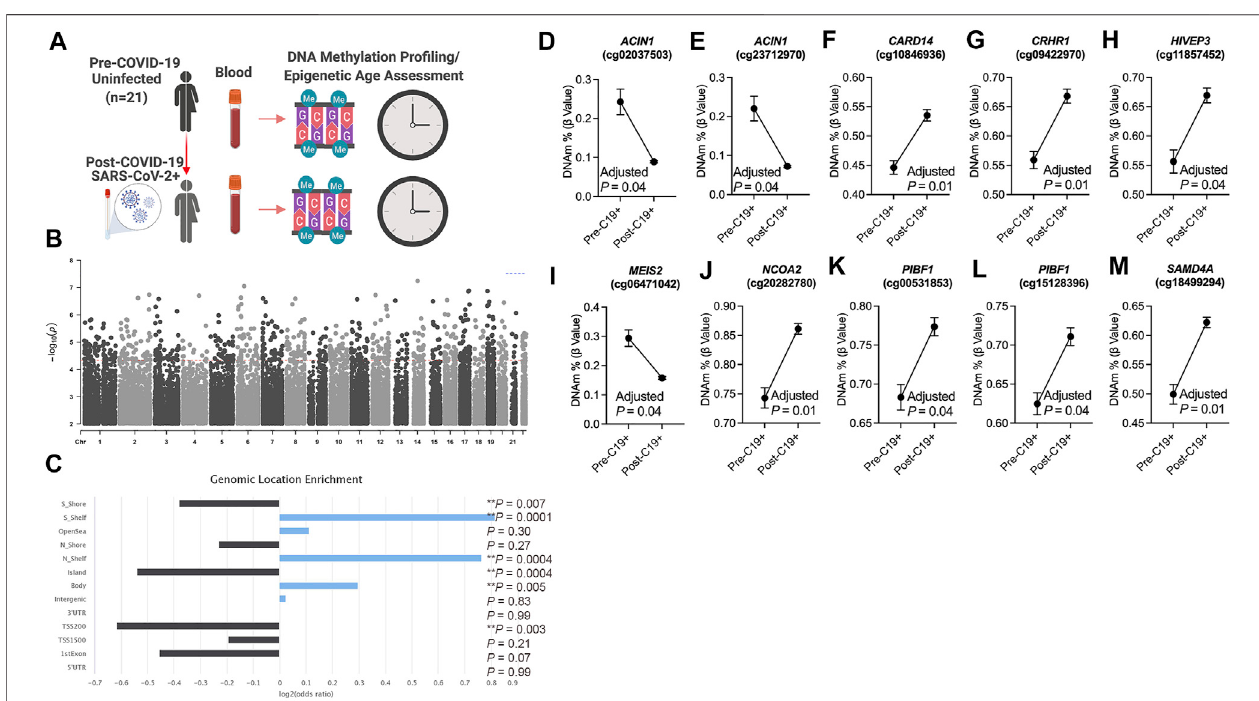
FIGURE1| DNAmethylationchangesinbloodassociatedwithmild/moderateCOVID-19 (A) .StudydesignoflongitudinalassessmentofDNAmethylationpro fi les in 21 participants pre- and post-SARS-CoV-2 infection (B) . Manhattan plot of differentially methylated loci (DML) associated with mild/moderate COVID-19 (C) . Bar graph of genomic enrichment of COVID-19 DML in 13 different categorized regions of the genome relative to gene and CpG island. Hypergeometric test utilized to calculate the p -value and odd ratio (D – M) . Plots of COVID-19 DML displaying mean DNA methylation levels ± SEM for CpGs associated with a gene ID. Adjusted p -value calculated utilizing Benjamini – Hochberg correction. Created with